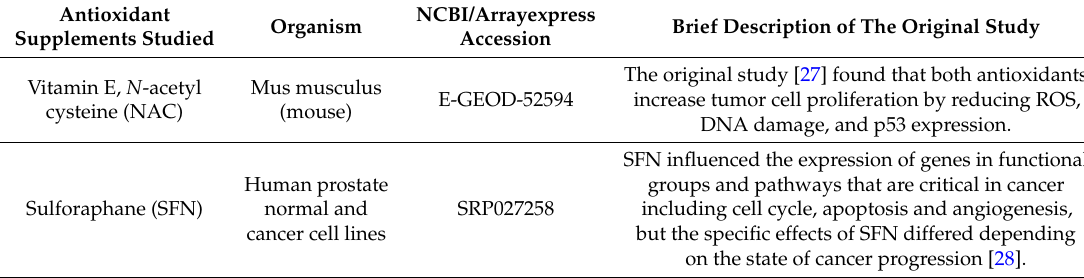
Table 1. RNASeq Datasets Downloaded from NCBI-SRA/ArrayExpress for